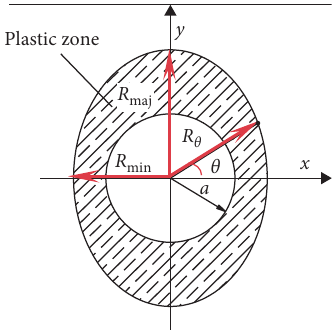
Figure 4: Special radii and boundary radium of the elliptical plastic area.